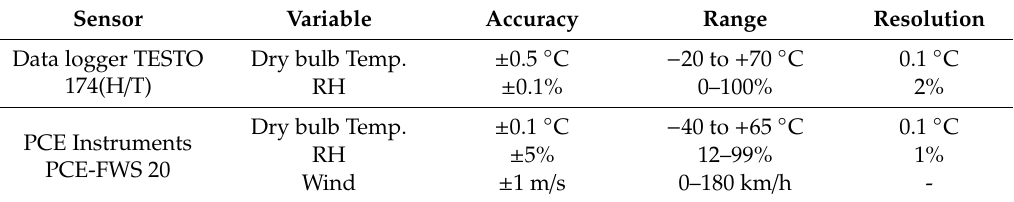
Table 2. Technical data of the measurement instruments.